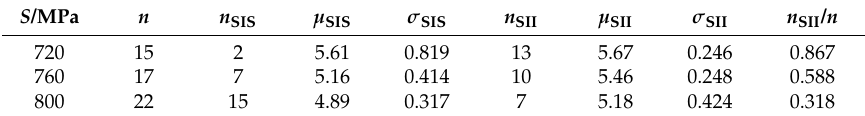
Table 4. LG parameters of SIS and SII under three stress levels.